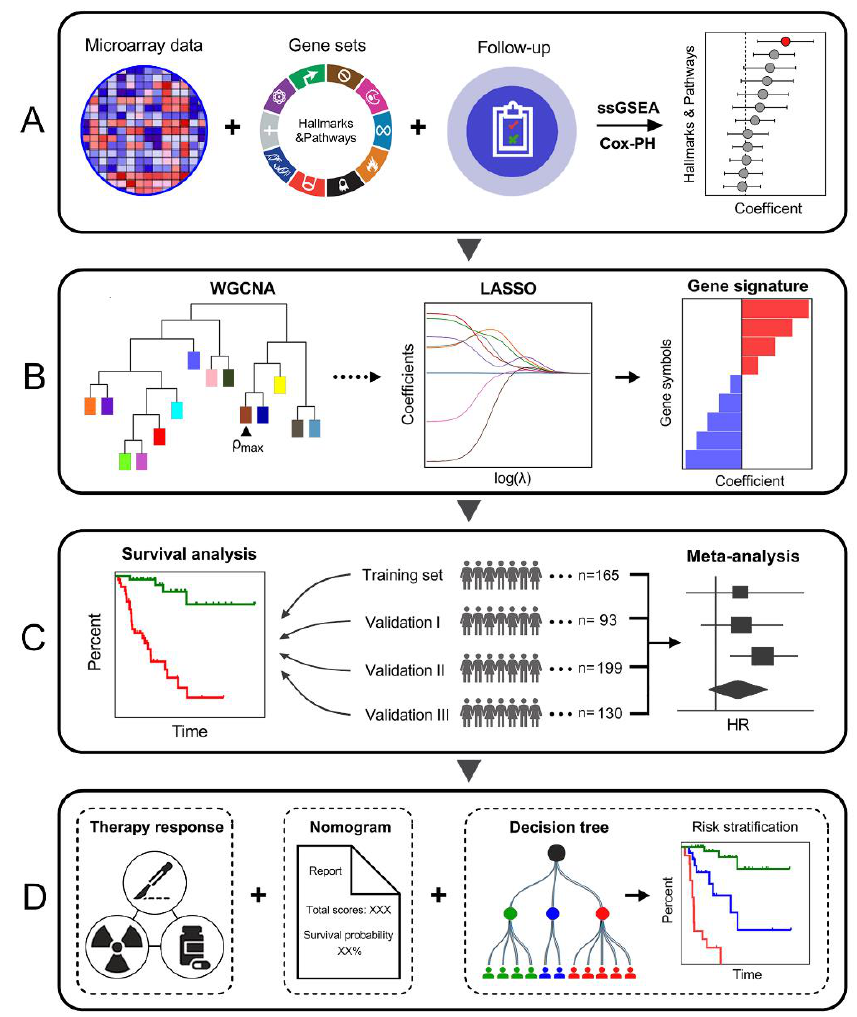
Figure 1. Schematic diagram of the study design. ( A ) Among various cancer-related hallmarks and pathways, cell cycle process (CCP) was identified as the dominant risk factor for cancer-specific survival (CSS) in bladder cancer (BCa) patients. ( B ) Combined methods were used to establish a robust CCP-related gene signature for CSS. ( C ) The prognostic value of the gene signature was further validated in di ff erent cohorts. ( D ) Clinical application.